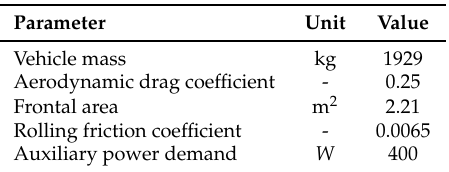
Table A1. Vehicle parameters.